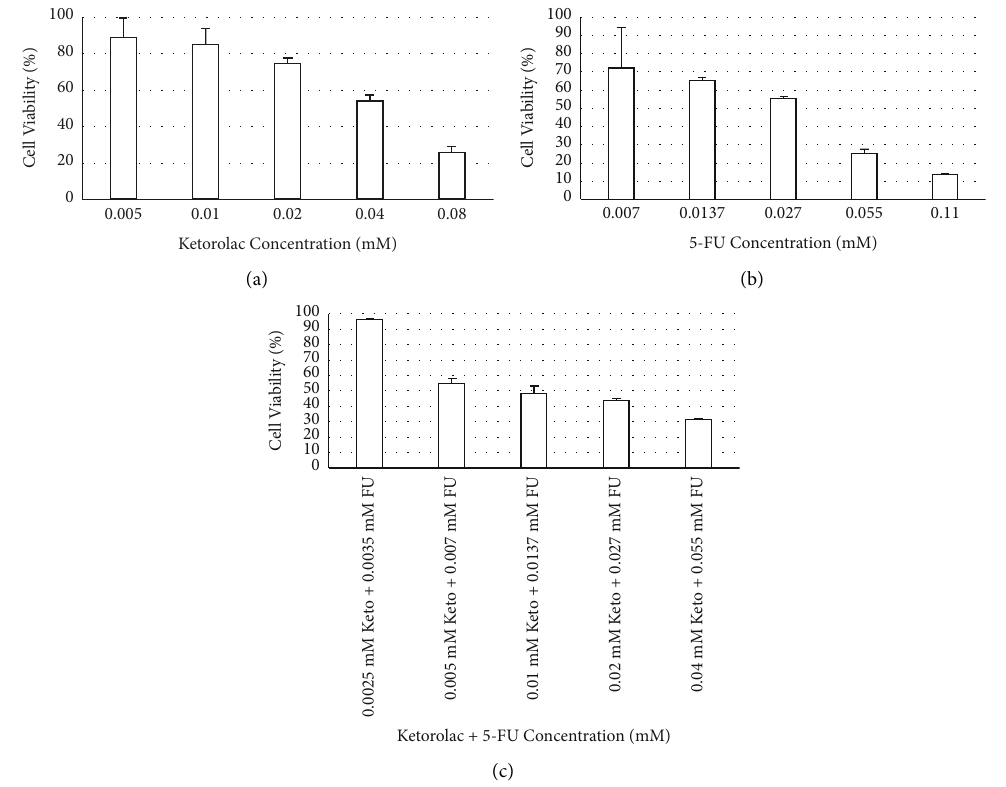
Figure 1: Viability (%) of HT-29 human colorectal cancer cells after 48 hours of treatment with various concentrations of ketorolac (a), 5- FU (b), and combination of them (c). Cell viability was determined by MTTassay and evaluated using a cell viability index (%), which was defined as: (mean absorbance in the test group/mean absorbance in the negative control group) × 100. Results are mean ± SD and sig- nificance level set at p ≤ 0 .